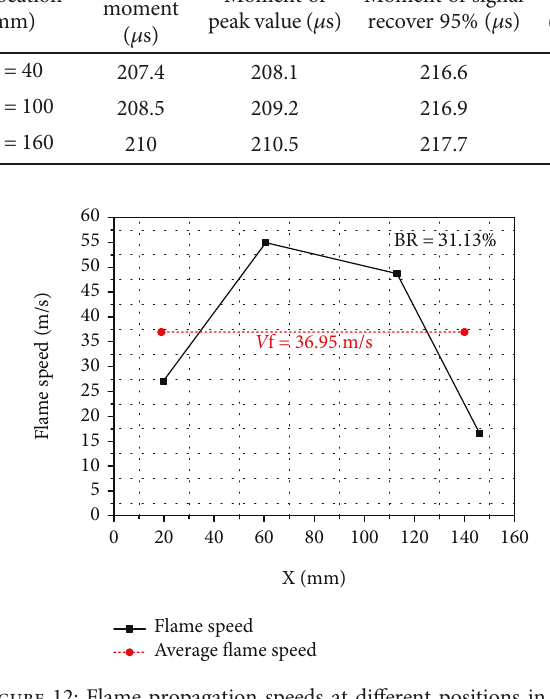
Figure 12: Flame propagation speeds at di ff erent positions in the combustion